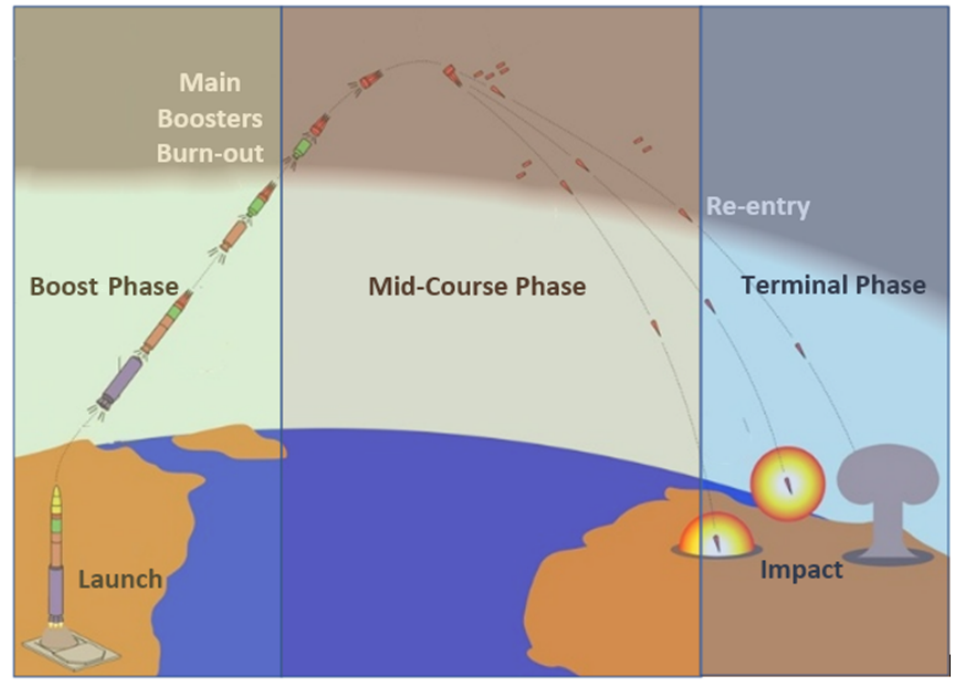
Figure 4. Flight path of Theater Ballistic